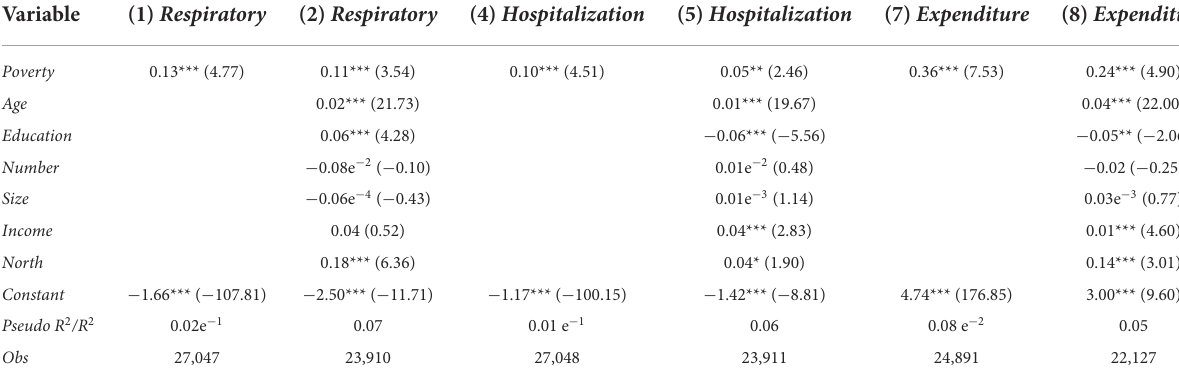
TABLE 2 Energy poverty and health